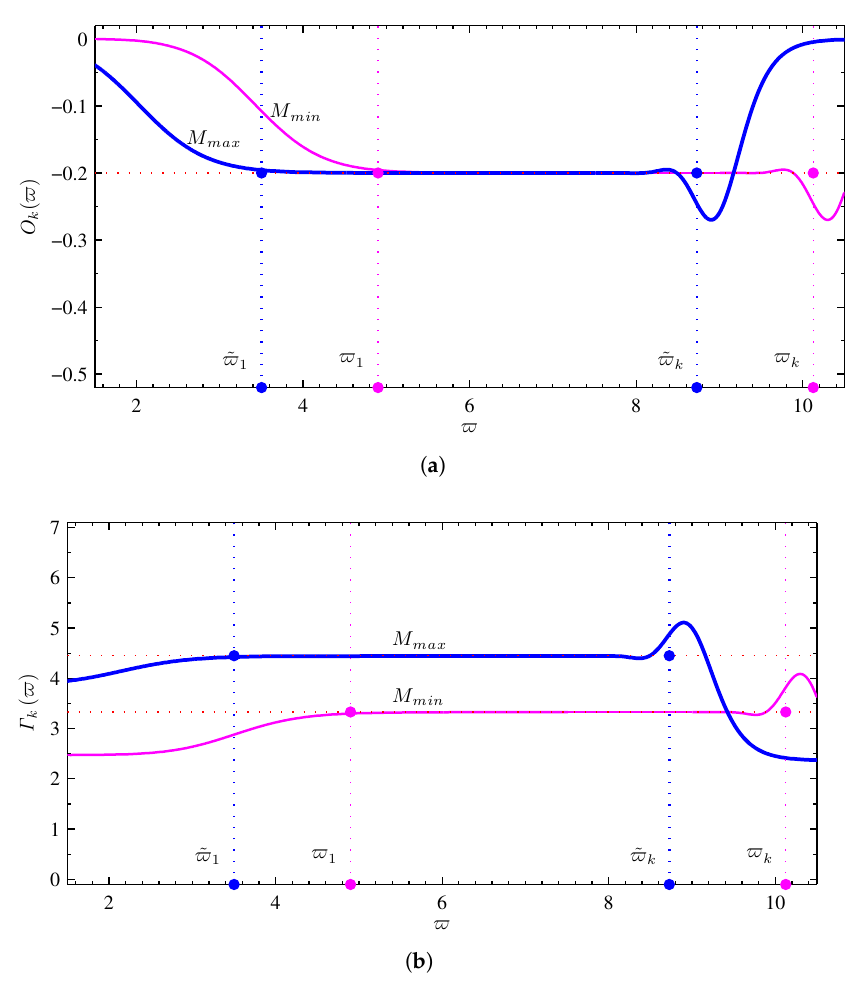
Figure 4. Frequency-domain characteristic curves of the chain-scaling fracmemristor circuit: ( a ) order- frequency characteristic curves; ( b ) F-frequency characteristic curves.